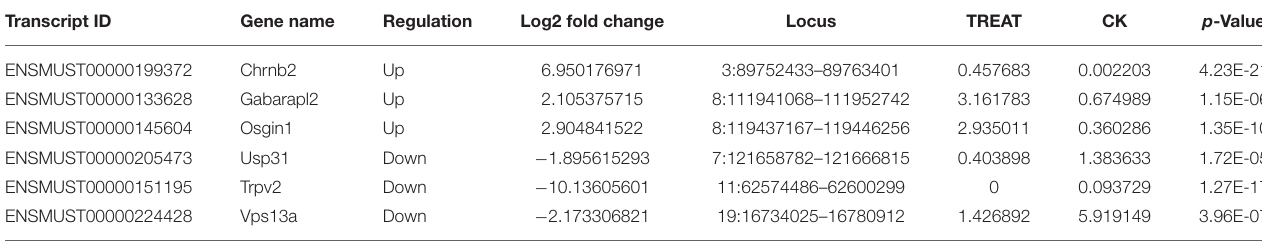
TABLE 1 | The list of the top 6 dysregulated known lncRNAs.